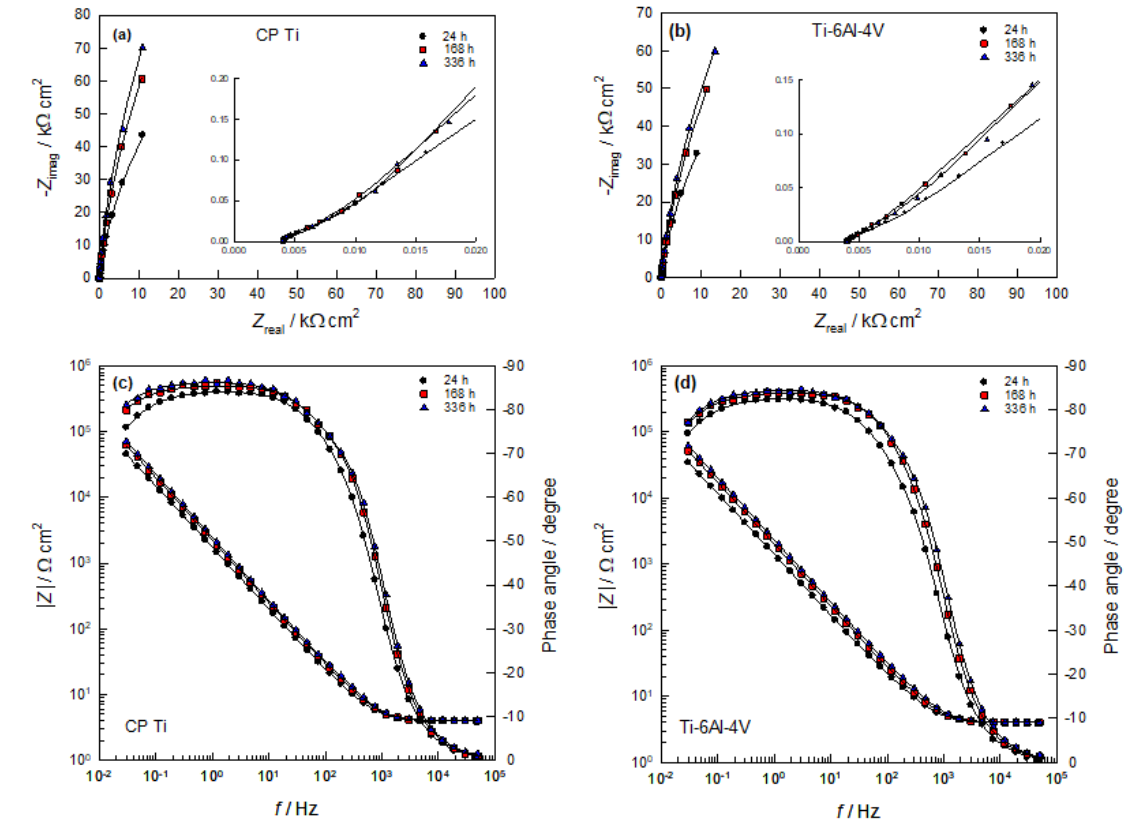
Figure 6. ( a , b ) Nyquist (insert: zoomed high-frequency part of impedance spectra) and ( c , d ) Bode plots recorded on CP Ti and Ti-6Al-4V alloy in PBS solution at different stabilization times on E OC.